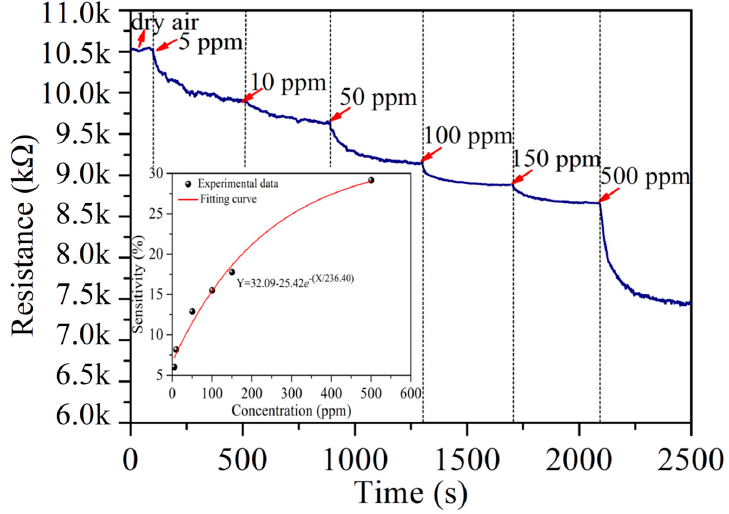
Figure 6. Resistance measurement of the Ag–SnO 2 /rGO nanocomposite film sensor upon exposure to acetylene gas with cumulated concentrations at 90 ◦